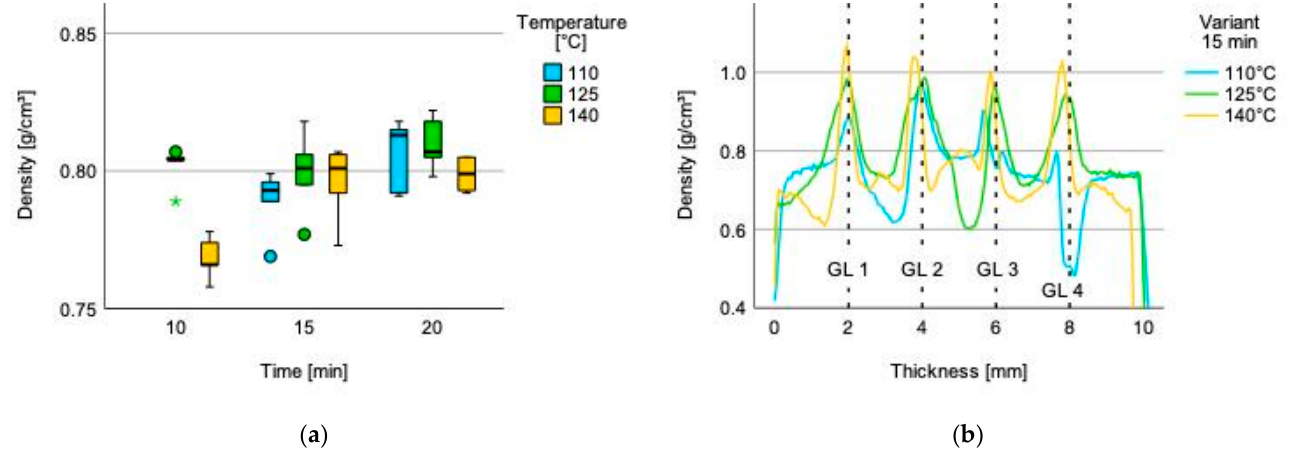
Figure 4. ( a ) Density grouped by time and temperature. Dots and stars within the box plot indicate outliers and ( b ) density profile for the 5-layers plywood glued for 15 min with Quebracho tannin- furfural adhesives at different temperature.